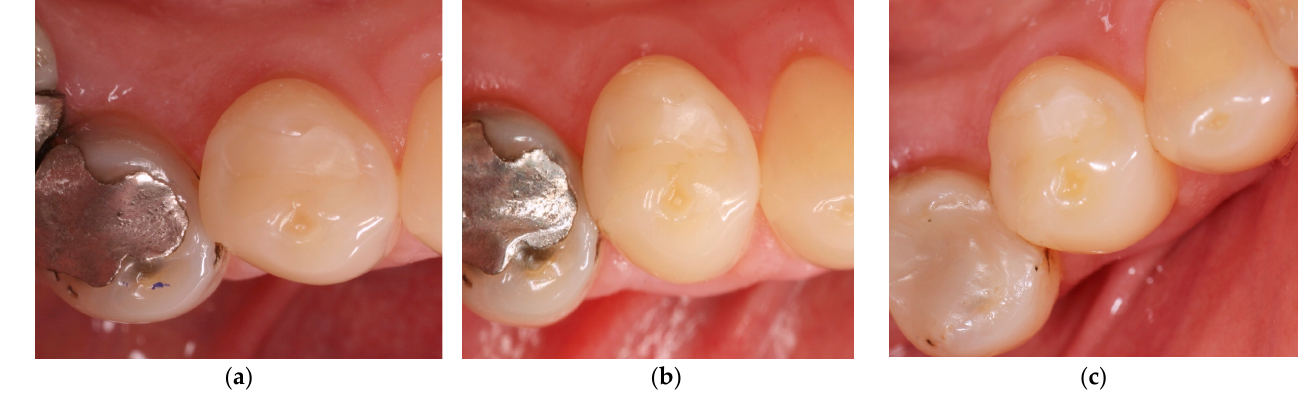
Figure 7. Clinical situation of Pat. No. 6: filling 44 od with flowable composite: test group, all crite- ria Code Alpha. ( a ) baseline; ( b ) after 12 months; and ( c ) after 24 months.